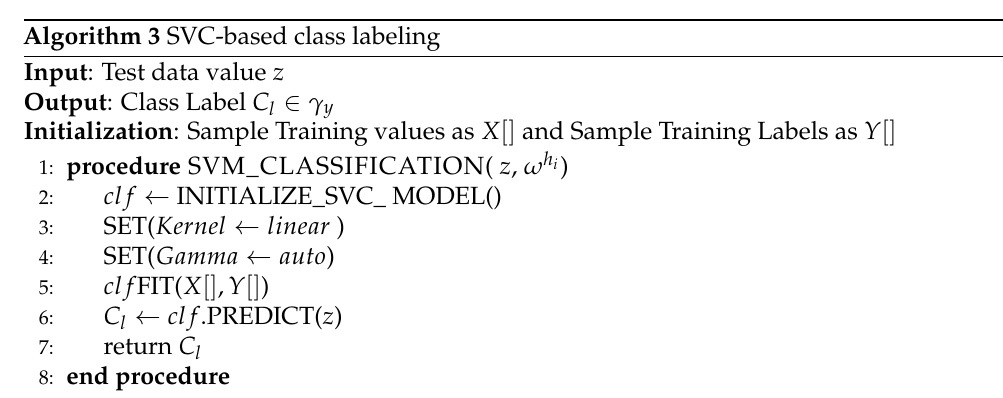
Algorithm 4 Loss classifier of the proposed